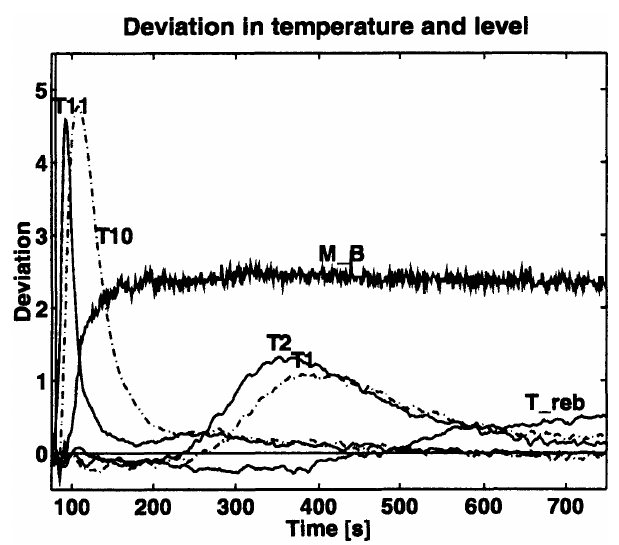
Figure 3. Deviation in temperature of reboiler, T and on stages 1, 10, 11 and the reboiler reb level response due to injection of a heavy tracer.